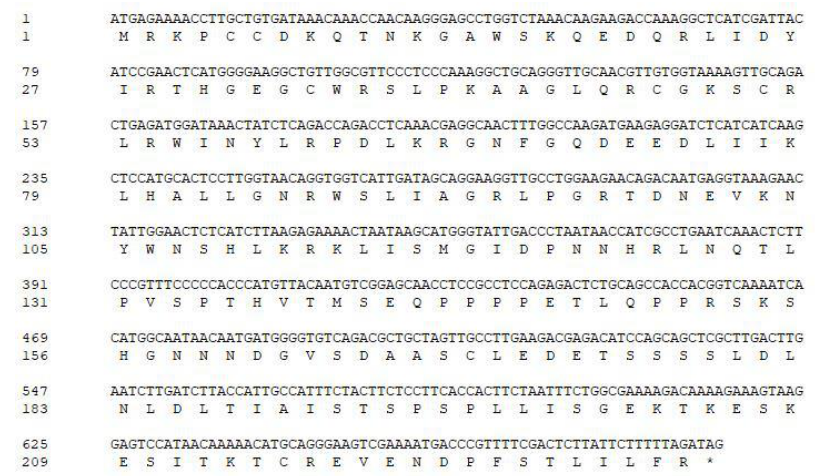
Figure 1. Nucleotide sequence and deduced amino acid sequence of PqMYB4 . The deduced amino acid sequence was shown underneath the corresponding nucleotide sequence, and stop code was indicated with *.